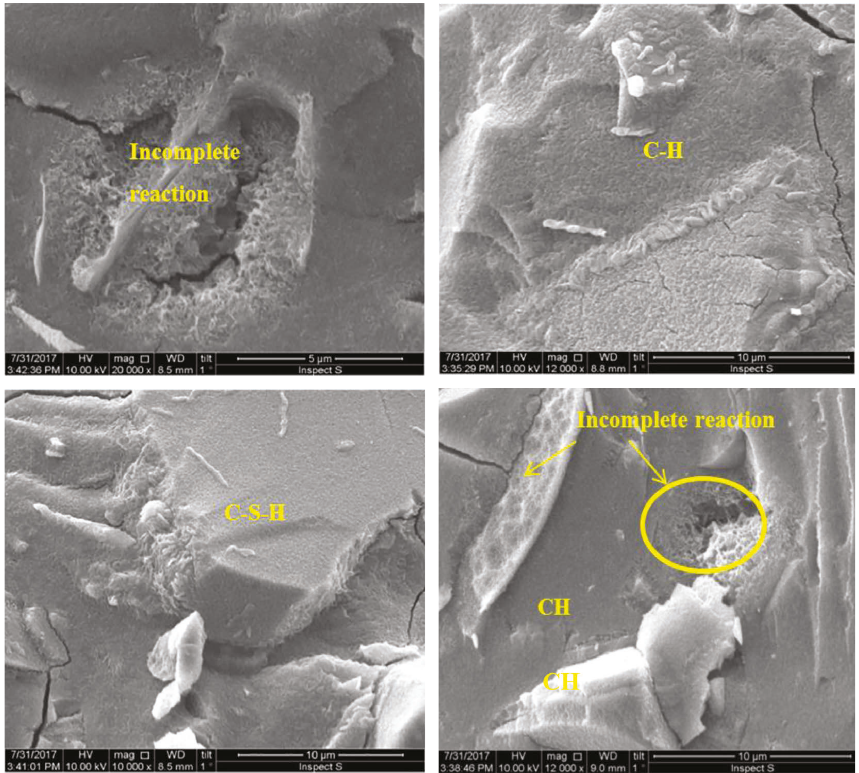
Figure 9: The SEM images for 95GMS geopolymer paste at 7 curing